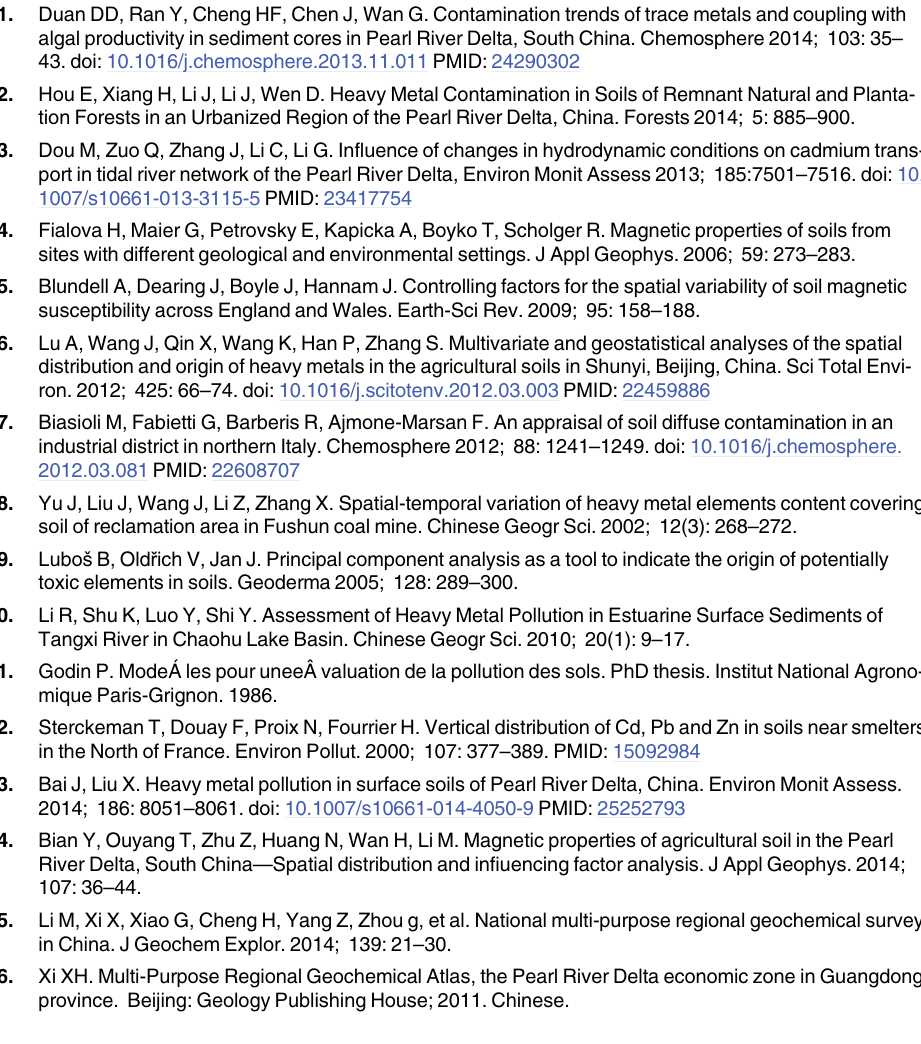
S5 Fig. Geochemical map of Arsenic in surface soil. (TIF) S6 Fig. Geochemical map of Arsenic in deep soil. (TIF) S7 Fig. Geochemical map of Lead in surface soil. (TIF) S8 Fig. Geochemical map of Lead in deep soil.